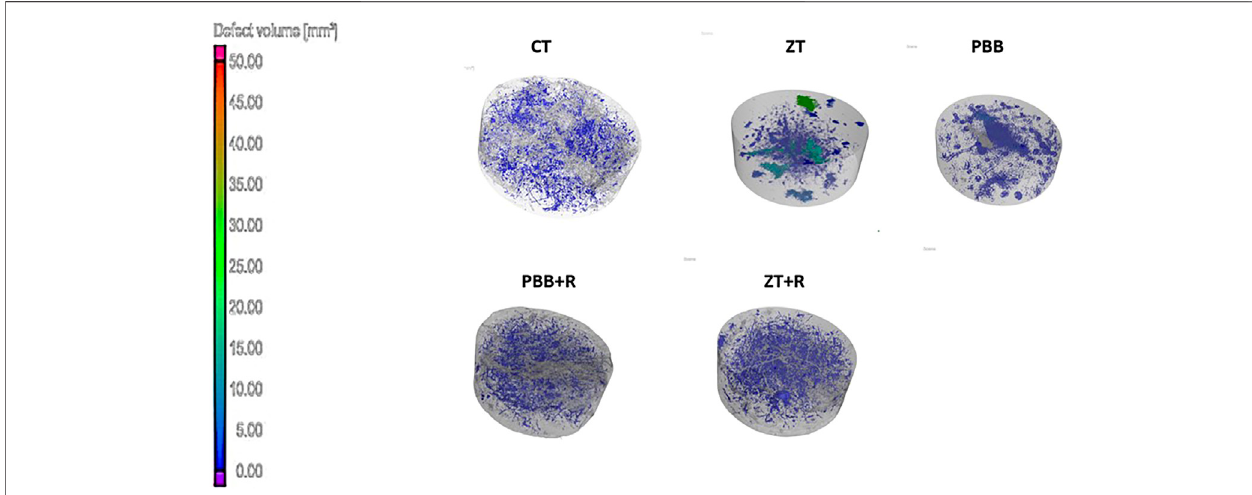
FIGURE1| Threedimensionalviewoftheporecharacteristicsofasoilcore(0 – 5 cmlayer)underconventionaltillage(CT)and zerotillagepracticeswithresidue (ZT + R), without residue (ZT), and permanent broad bed (PBB) with residue (PBB + R).